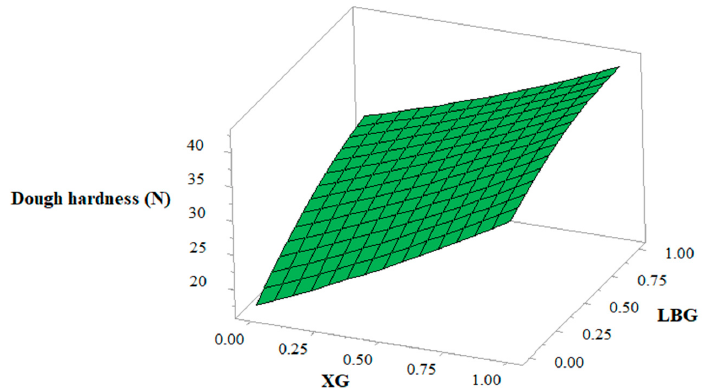
Figure 1. Response surface showing the effect of xanthan gum (XG) and locust bean gum (LBG) on dough hardness.